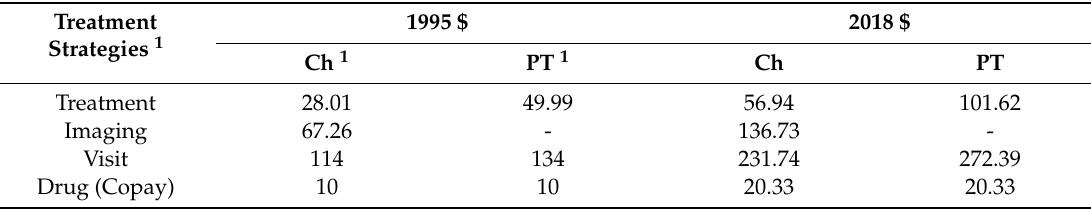
Table 2. Detailed costs of treatment strategies for the years 1995 and